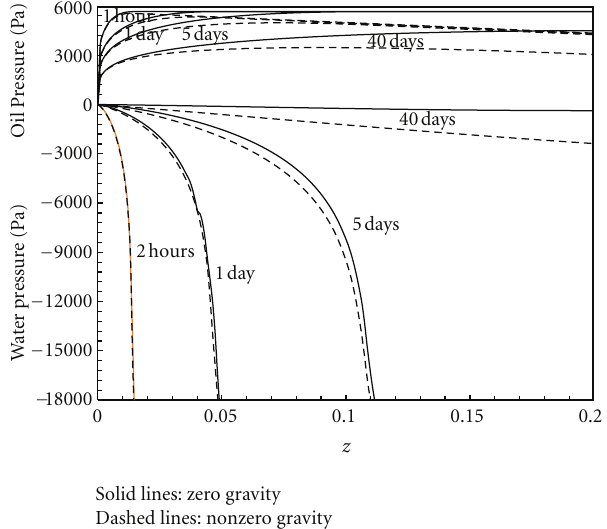
Solid lines: zero gravity Dashed lines: nonzero gravity Figure 10: Comparison between considering and neglecting gravity e ff ect on water and oil pressure against z -axis of Case C, at x = 0 .